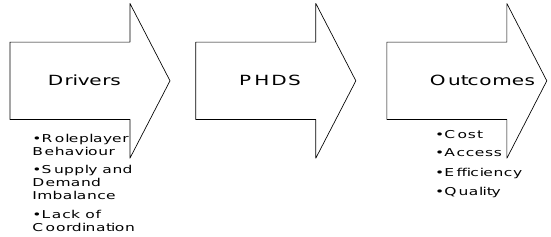
Figure 9: The PHDS – Its drivers and